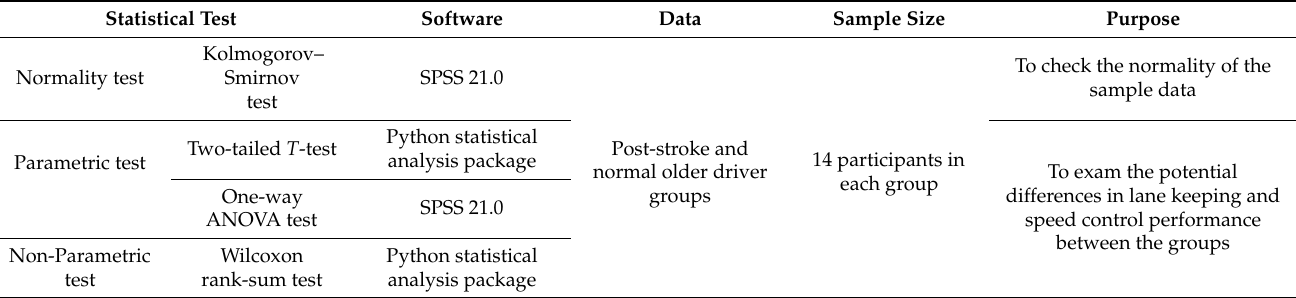
Table 1. Tests and